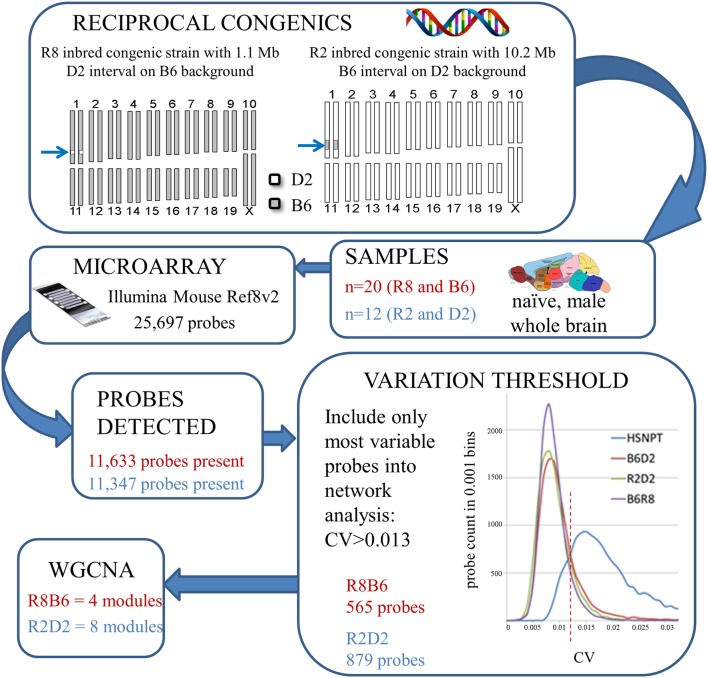
Microarray and parallel weighted gene co-expression network analysis (WGCNA) workflow summary for each comparison of congenic and background strain.